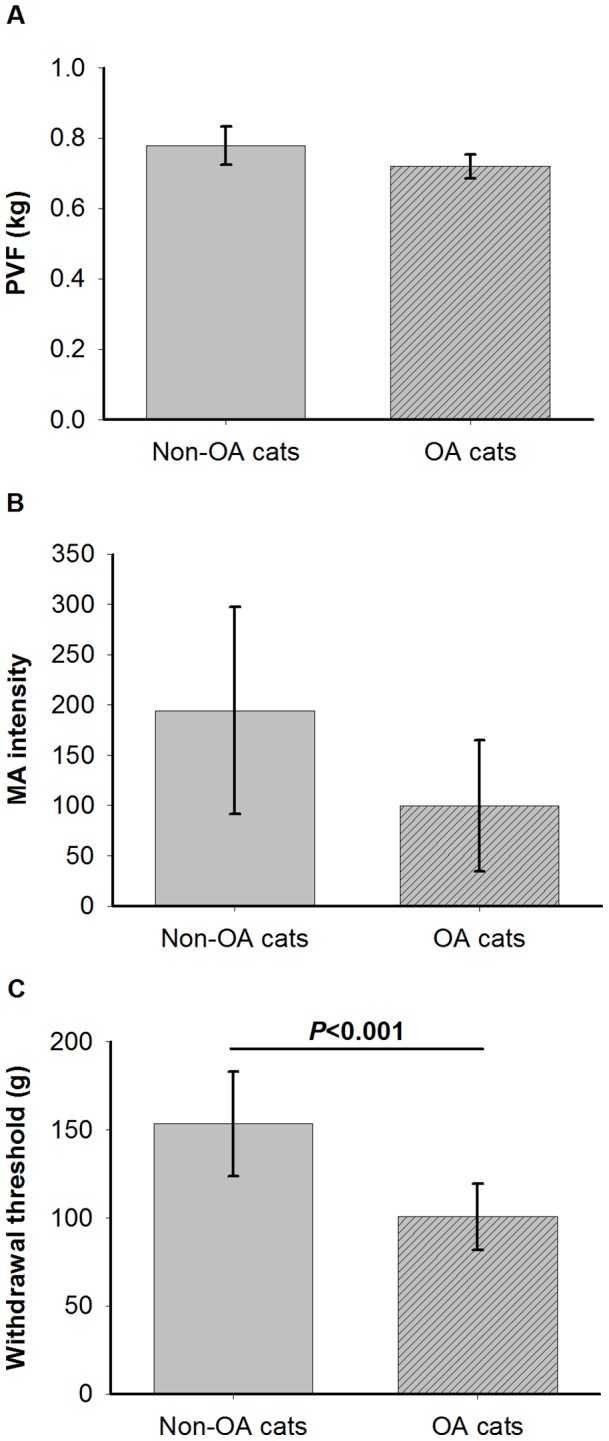
Characterization of osteoarthritis (OA) using chronic pain evaluation methods: A- Least squares means and 95% confidence interval of the log-transformed most affected limb peak vertical ground reaction force (PVF) after-exercise by OA status.B- Least squares means and 95% confidence interval of the motor activity (MA) intensity by OA status. C- Least squares means and 95% confidence interval of the log-transformed von Frey anesthesiometer-induced paw withdrawal threshold by OA status.